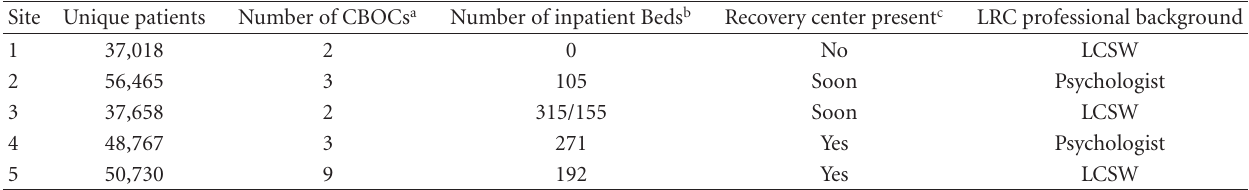
Table 2: Site-level characteristics of VA healthcare systems participating in piloting